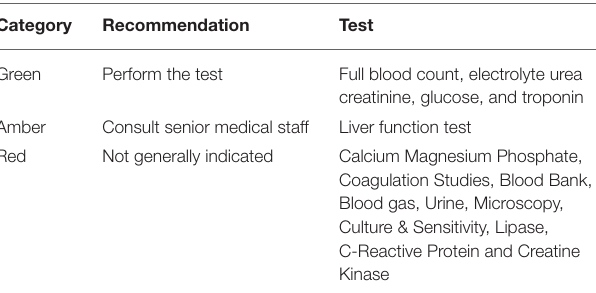
TABLE 1 | STOP principles for adults presenting to ED with chest